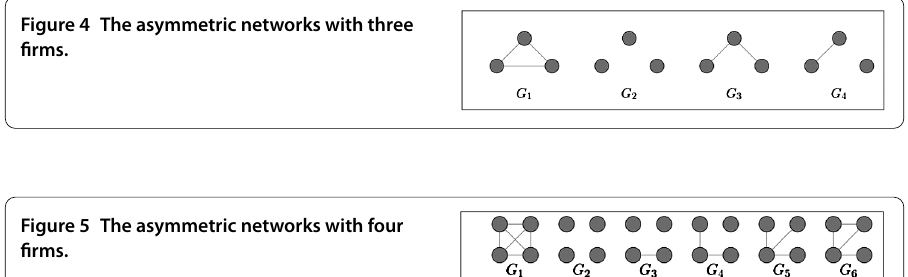
Figure 5 The asymmetric networks with four firms.